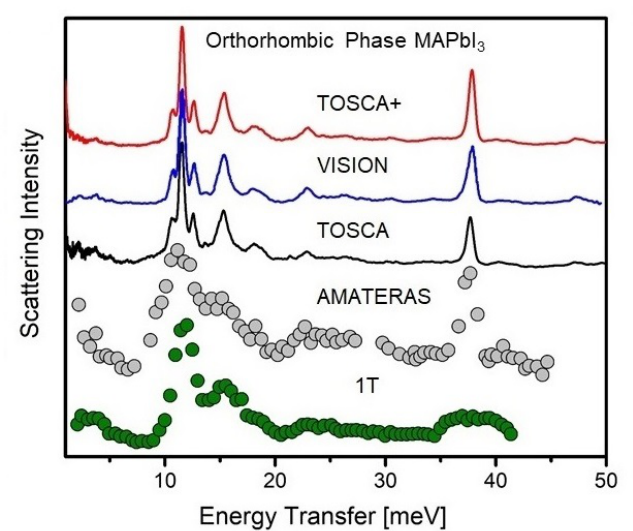
Figure 5. INS spectra of hydrogenous MAPbI 3 in the orthorhombic phase at low temperatures (T = 5–20 K). These spectra were recorded on five different instruments: 1T (TAS; single-crystal [116]); AMATERAS (TOF; E i = 54 meV; single-crystal [121]; TOSCA [144], VISION [109], TOSCA+ [75] (indirect-geometry; powders). Adapted with permission from Refs. [75,109,116,121,144]. Copyright (2021) American Chemical